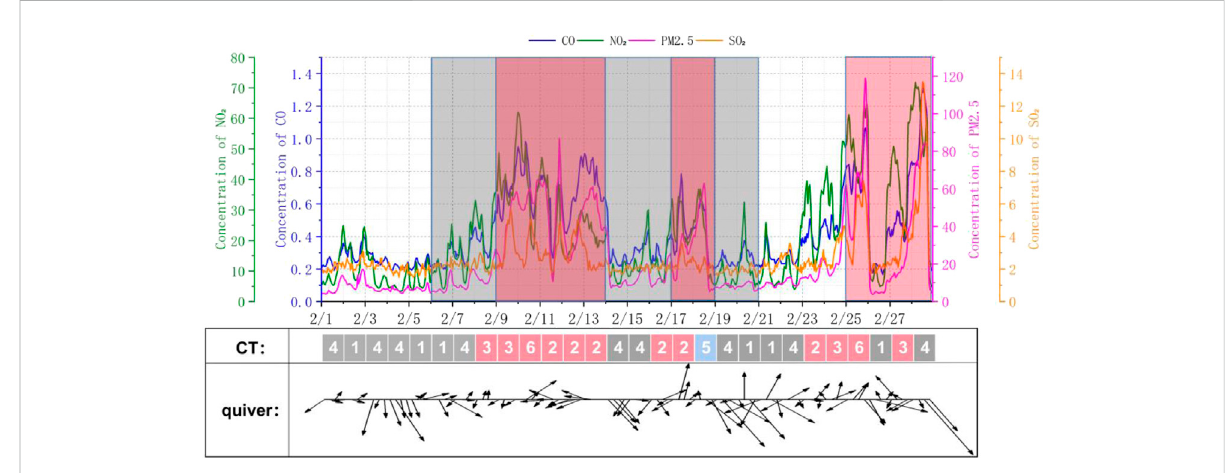
FIGURE 5 Hourly concentration changes of the four major pollutants (PM 2.5 , NO 2 , SO 2 , and CO) as well as the time series of circulation patterns and wind fi elds in Beijing in February 2022. The gray sections represent the Beijing winter Olympics (from 4 February 2022 to 20 February 2022), and the red sections represent the period of pollution